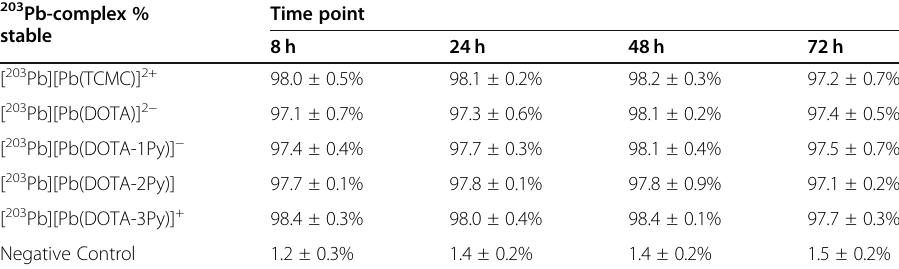
Table 2 In vitro stability of 203 Pb-labeled chelator complexes at 37 °C in human serum ( n = 3) 203 Pb-complex %